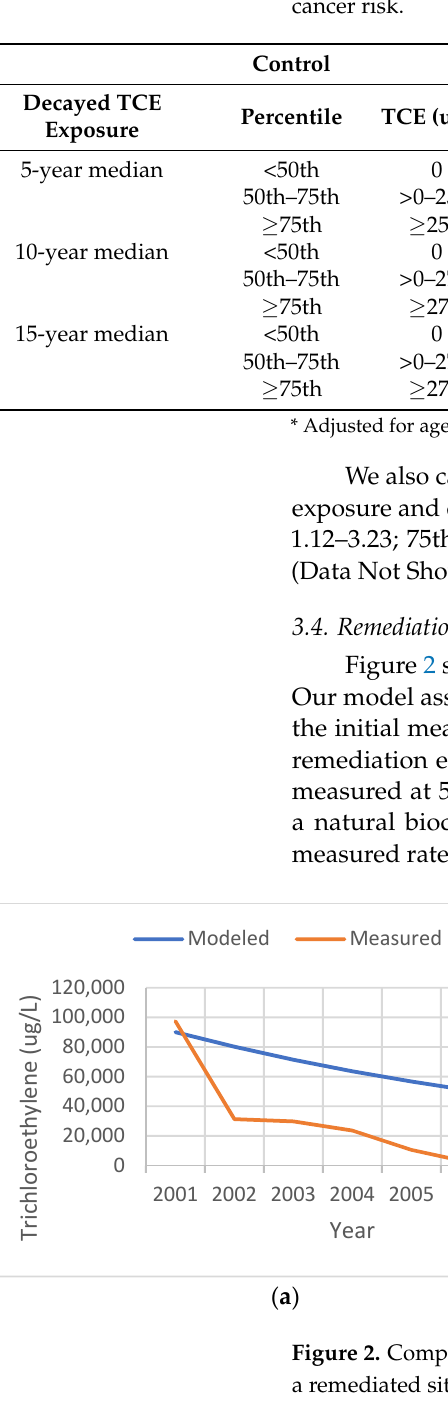
Table 2. Estimated groundwater trichloroethylene contamination in New Hampshire and kidney